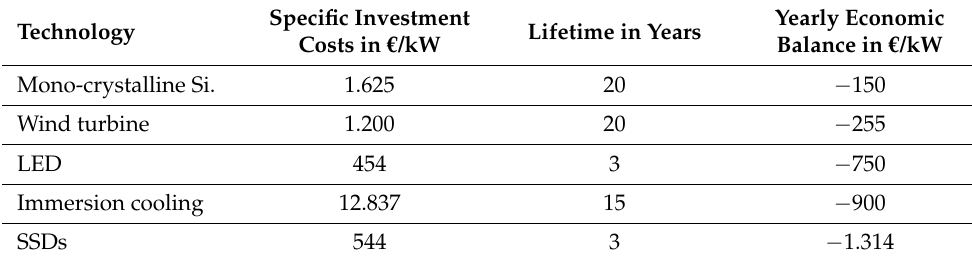
Table 6. Economic indicators of the planning